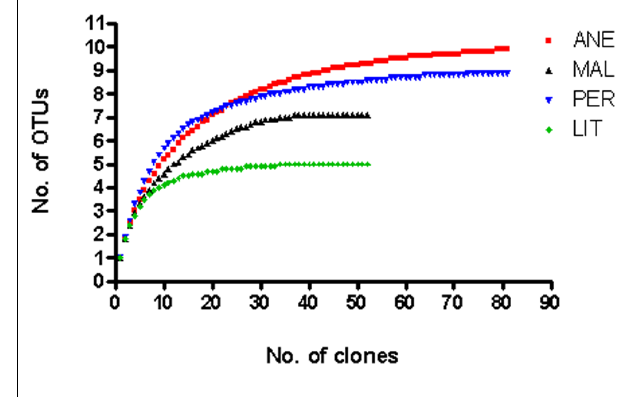
FIGURE 3 | Rarefaction curves determined for the different 18S rRNA gene clones. Rarefaction curves indicating the observed number of operational taxonomic units (OTUs) at a genetic distance of 3% in four different glaciers.